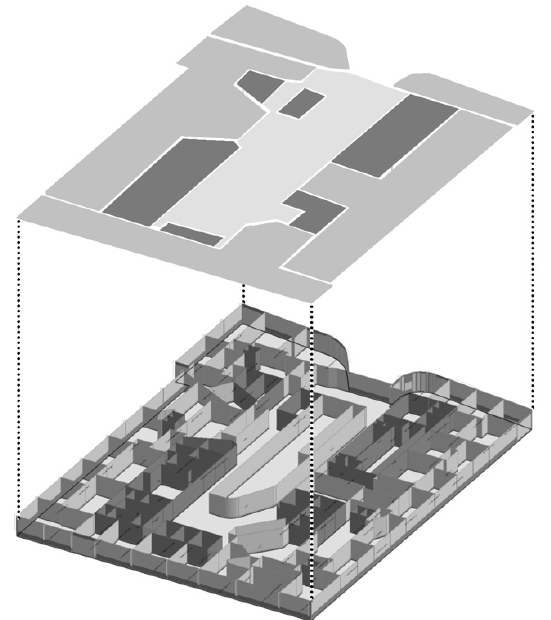
Figure 1. Floorplan of floor 8 for the thermal simulation. The fine-grained model (below) reports existing wall partitions in grey and fictitious partitions used only to divide the space into different thermal zones in yellow. In the simplified model (above) the grey areas are delimitated by real partitions, while the red zones are thermal zones only.